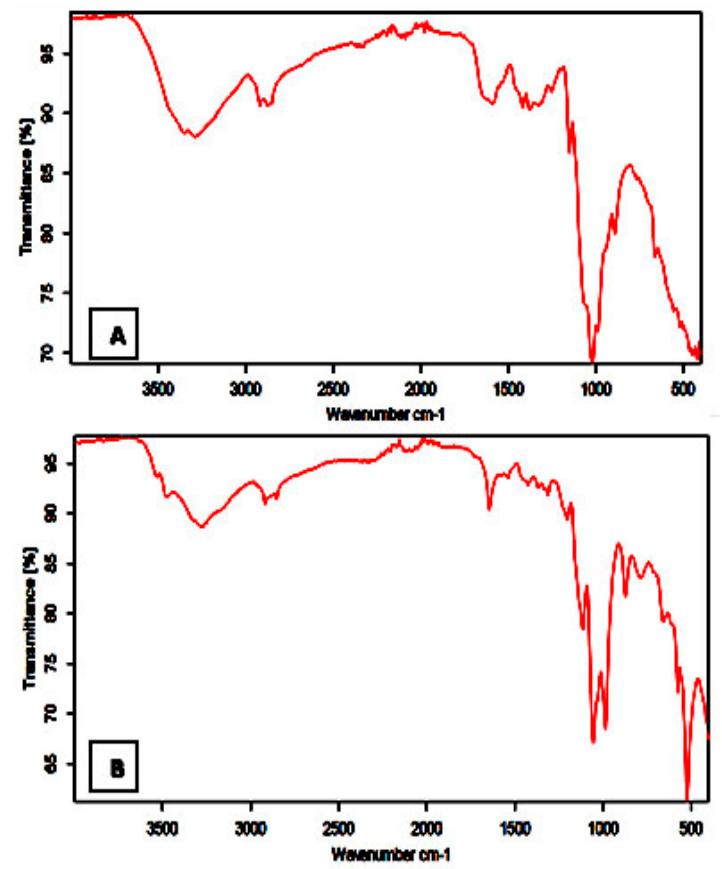
Figure 2. Infrared spectra of: ( A ) free ligand chitosan and its ( B ) Se/Chitosan complexity.